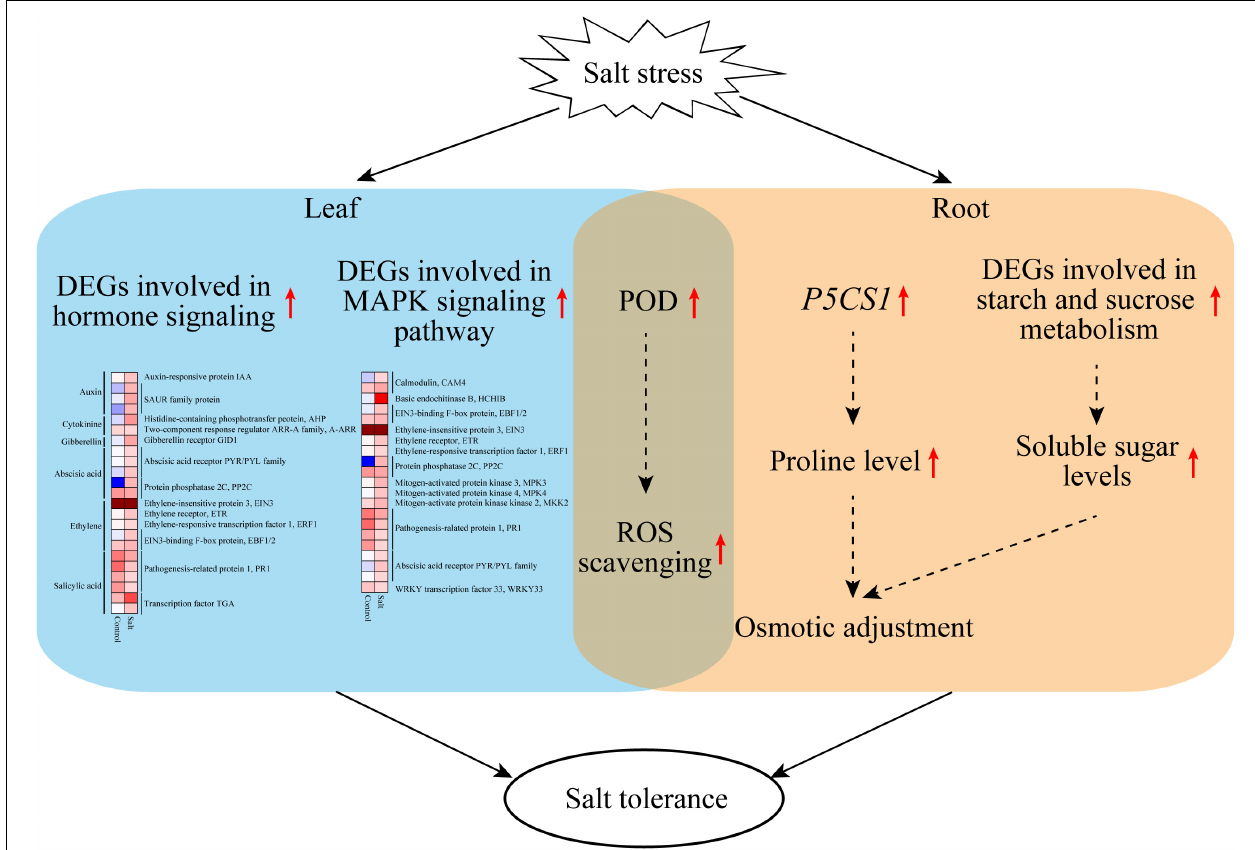
FIGURE 8 | A model proposed potentially to explain the high salt tolerance of F. velutina R7. Under salt stress, R7 activates multifaceted defense machines in the roots and leaves to enhance salt tolerance. In the R7 root, salt stress induces the upregulation of P5CS1 and the key genes involved in starch and sucrose metabolism, therefore increasing osmotic adjustment. In the R7 leaf, salt stress induces the upregulation of important genes involved in plant hormone signaling (especially PYR1/PYL/RCAR ABA receptor genes and PP2C ) and MAPK signaling pathways (especially CAM4 , MPK3 , and WRKY33 ). In addition, salt stress induces the upregulation of POD genes in both roots and leaves, so enhancing ROS scavenging